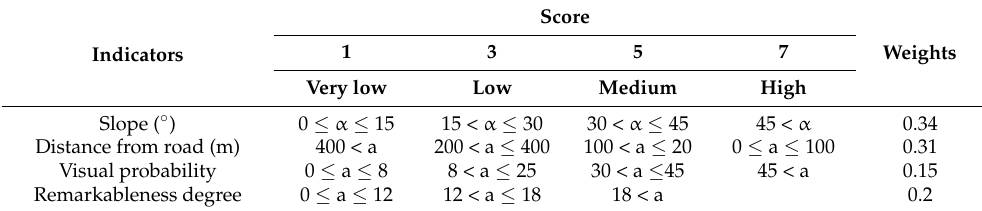
Table 2. Classification criteria of landscape visual sensitivity.